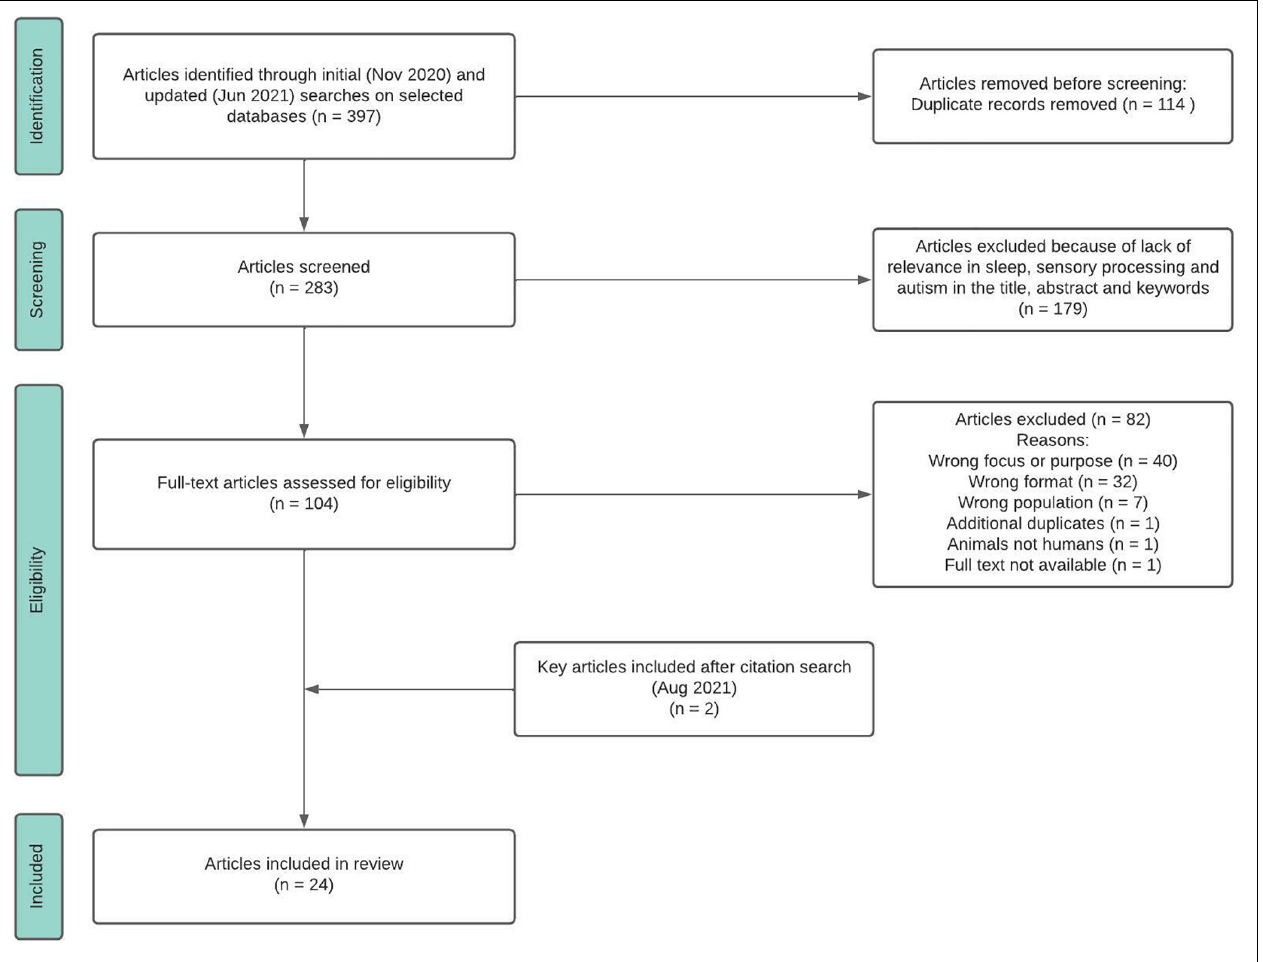
FIGURE 1 | Preferred Reporting Items for Systematic Reviews and Meta-Analyses (PRISMA-